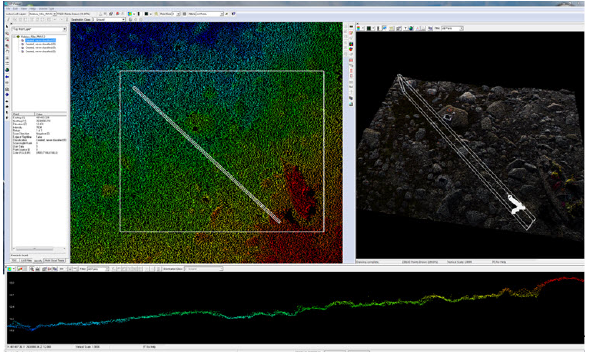
Figure 5: Point cloud showing the detailed micro-topography captured by the PMVS2 technique.